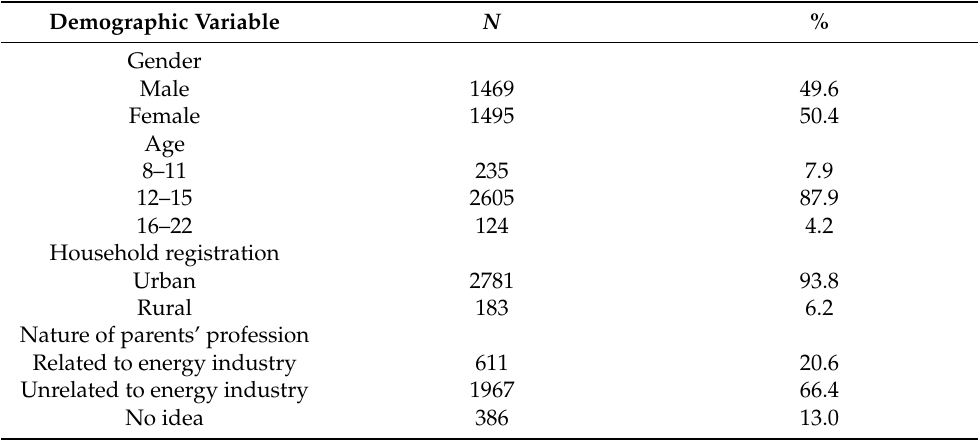
Table 1. Participants demographic characteristics ( N =